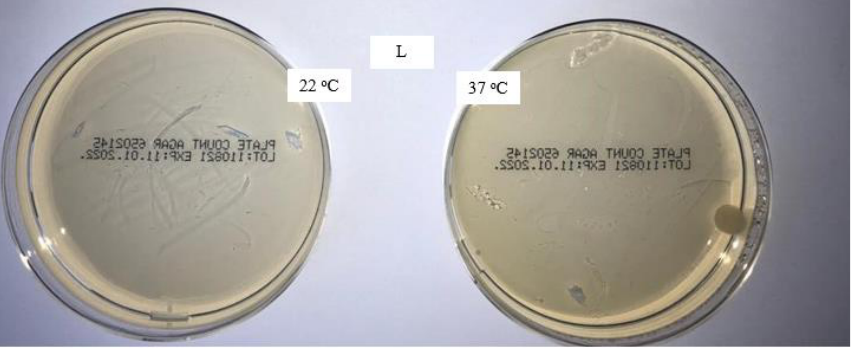
Figure 3. Colonies of aerobic microorganisms on a medical mask after laboratory washing (L 5 × ).